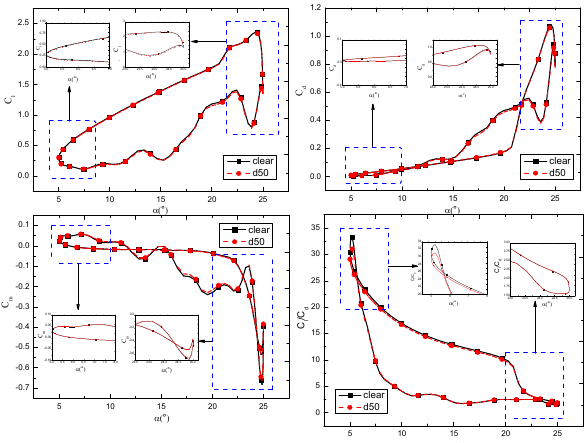
Figure 4. Aerodynamic performance curve graph.